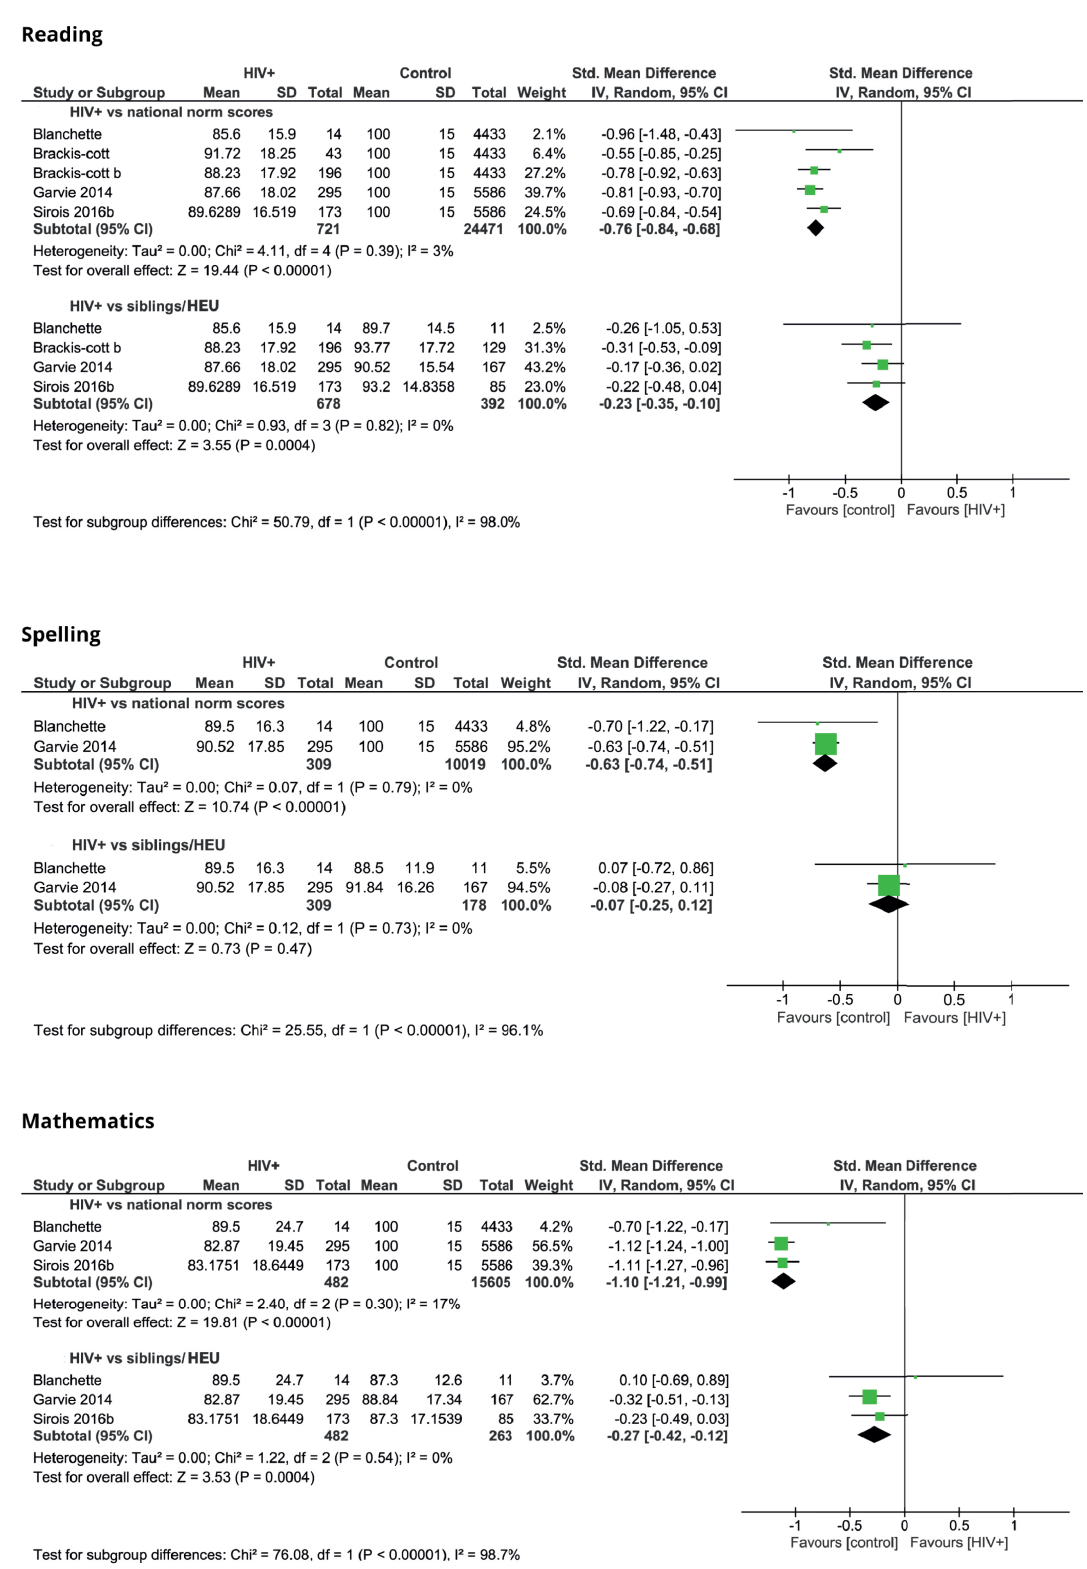
Fig 3. Reading, spelling and mathematic scores of children with HIV compared to control groups.